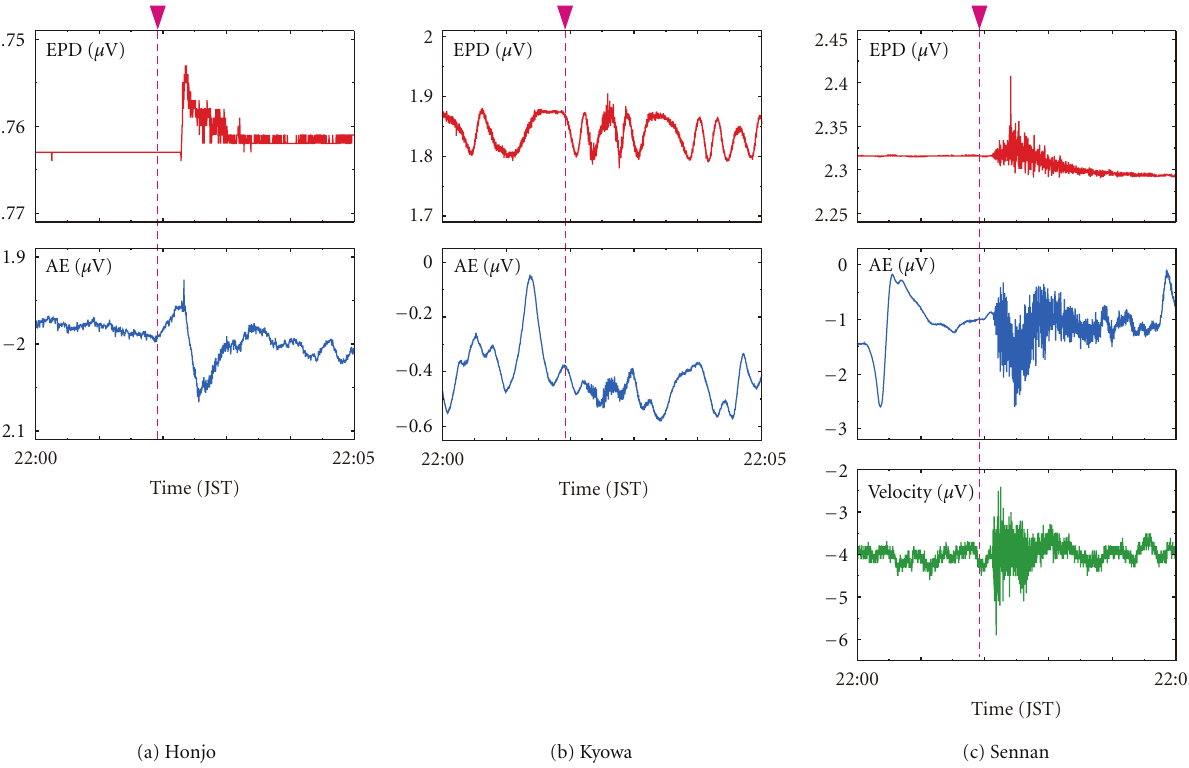
Figure 3: Raw data recorded before and after the arrival of seismic waves from a M6.3 earthquake: (a) at Honjo, (b) at Kyowa, and (c) at Sennan. Upper row graphs show raw data of the earth potential di ff erence (EPD). Middle ones show raw data of the signals related to the atmospheric electricity (AE). Lower one shows raw data of the ground velocity (only at Sennan). Broken lines show the origin time. The time is in JST ( = UT + 9 hr).